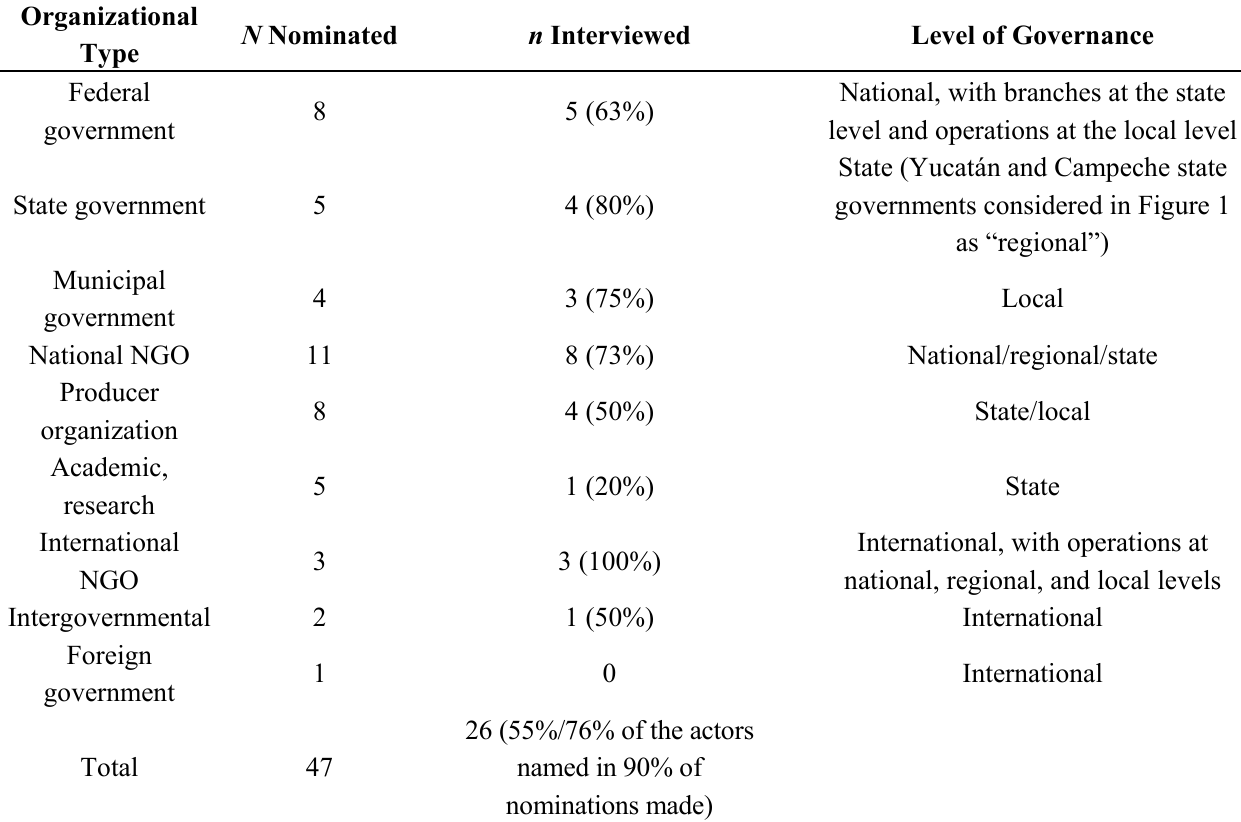
Table 1. Nominated and interviewed organizational